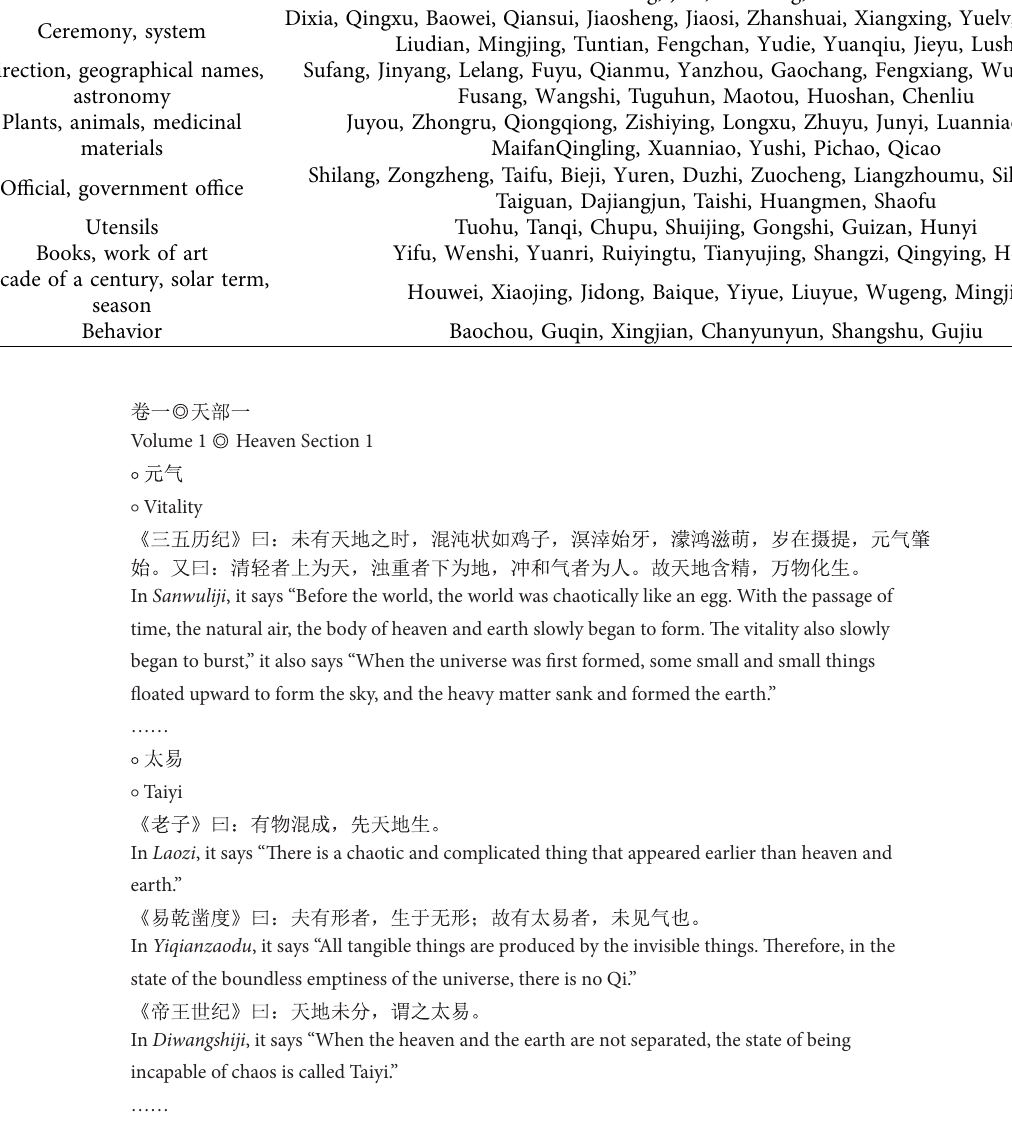
Figure 2: The hierarchical textual structure in Temporal Imperial